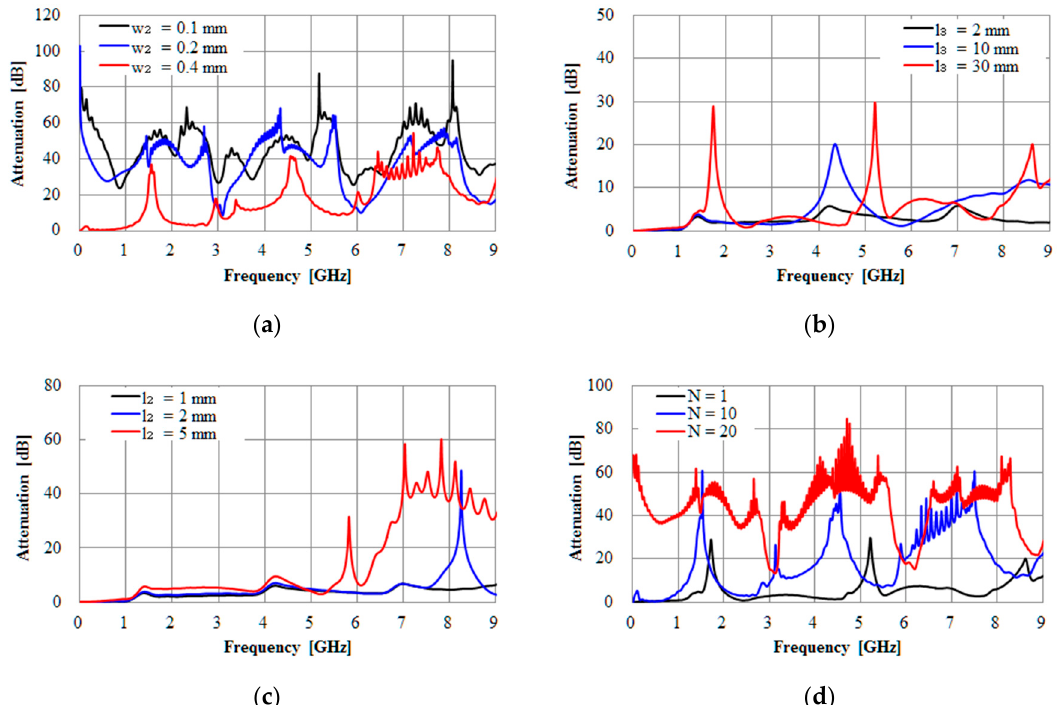
Figure 8. Lateral wave attenuation of the unit cell of the meander slot line obtained by Figure 4. ( a ) Split gap width w 2 changed (when l 1 = 0.25 mm, l 2 = 0.4 mm, l 3 = 30 mm, w 1 = 2.1 mm, w 2 = w 3 ); ( b ) length l 3 changed (when l 1 = 0.25 mm, l 2 = 0.4 mm, w 1 = 2.1 mm, w 2 = w 3 = 0.2 mm); ( c ) length l 2 changed (when l 1 = 0.25 mm, l 3 = 2 mm, w 1 = 2.1 mm, w 2 = w 3 = 0.2 mm); ( d ) number of cells changed (when l 1 = 0.25 mm, l = 0.4 mm, l = 30 mm, w = 2.1 mm, w = w = 0.2 2 3 1 2 3